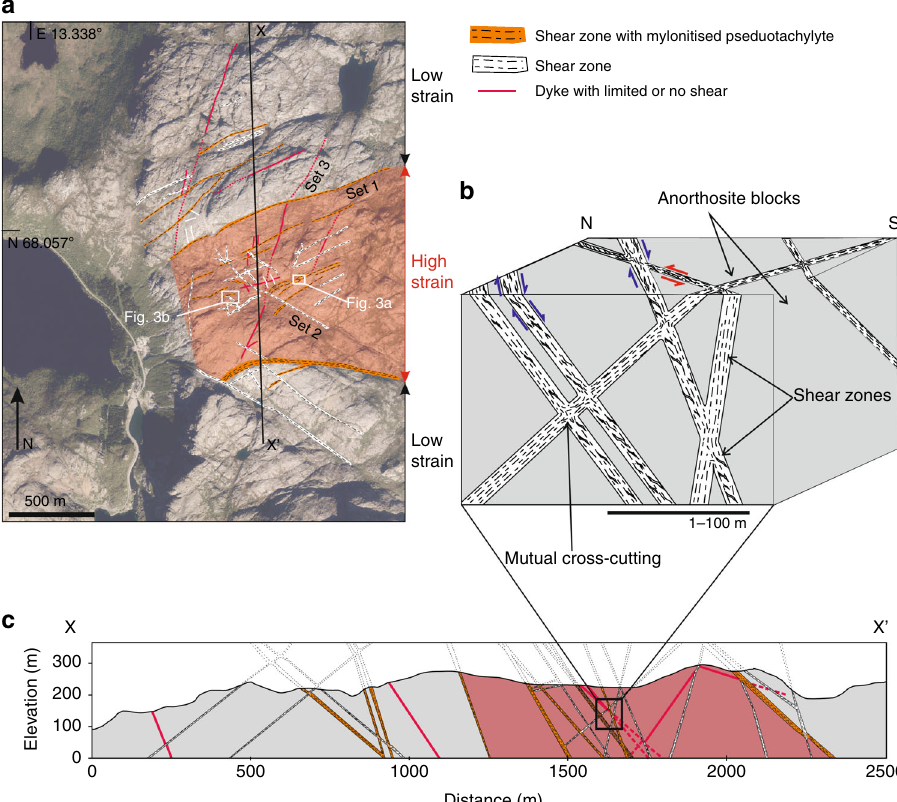
Fig. 1 Structure of the Nusfjord region. a Map of Nusfjord anorthosite showing locations of shear zones and large dykes. Red shading indicates the extent of the high strain zone containing frequent cross-cutting shear zones. Basemap © OpenStreetMap contributors (openstreetmap.org.uk/copyright). b Block diagram showing three-dimensional structure of interlocking shear zones in various orientations. c Cross section taken from line X – X ′ shown on map in 1a. The thickness of shear zones in the map is not representative of the actual thickness in fi